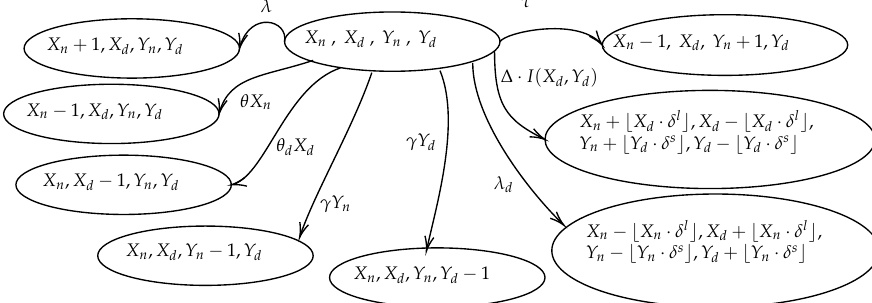
Figure 7. Markov chain of the P2P network under a DoS attack.